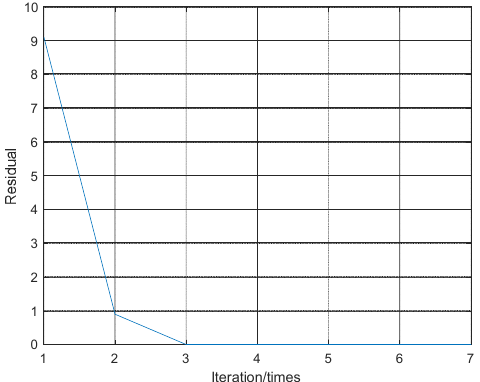
Figure 3. Residual convergence curve.